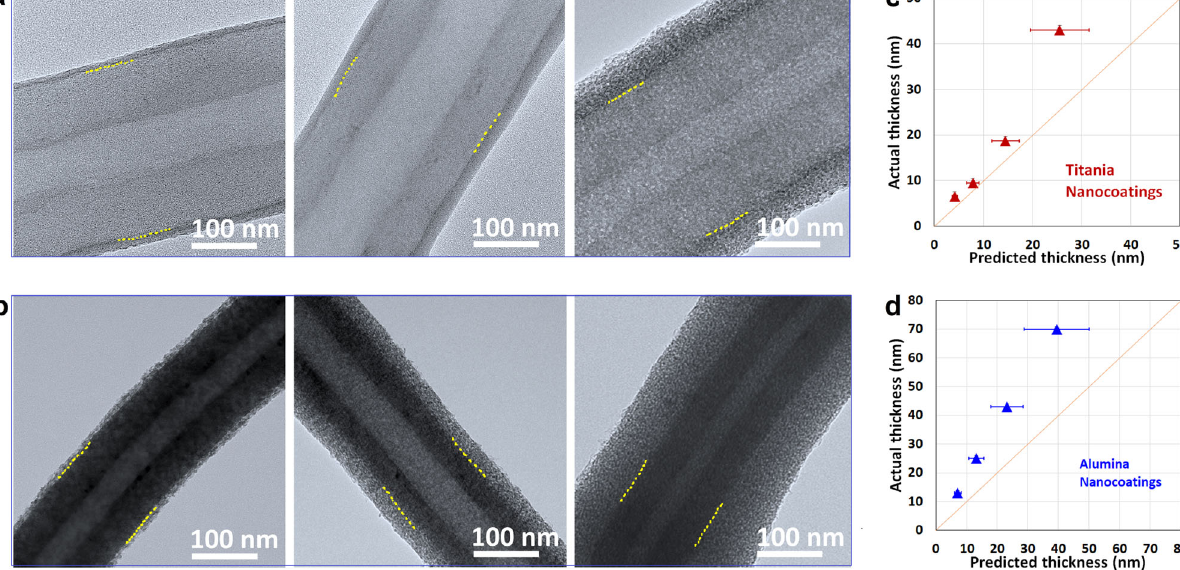
Fig. 3 Nanocoating deposition of different thicknesses. a TEM images of titania nanocoatings on CNTs showing three different thicknesses, with the yellow dash-dotted lines as guide for the eye. b TEM images of alumina on CNTs showing three different thicknesses. c Predicted and actual thicknesses of titania nanocoatings, with the diagonal line indicating the same thicknesses. The error bars are estimates in calculating the predicted thicknesses, see Supplementary Table 1. d Predicted and actual thicknesses of alumina